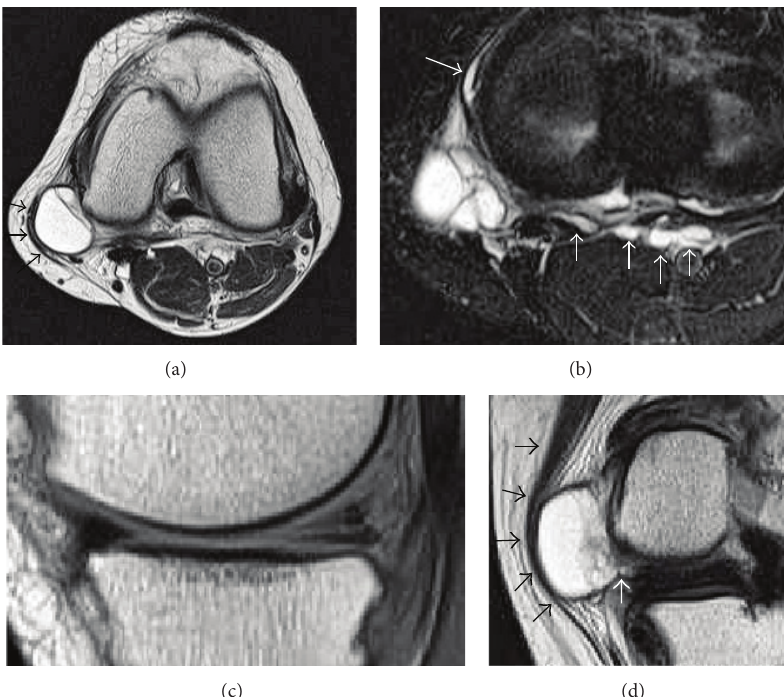
Figure 1: Preoperative magnetic resonance images of the left knee. (a) T2 weighted axial MRI shows a cystic mass measuring 23 mm × 20 mm detected on the posteromedial aspect of the knee. Flattened sartorius muscle (arrows) is noted just over the cyst. (b) Multiple daughter cysts expanding from the main large cyst to posterior and anterior directions were noted on STIR axial image (arrows). (c) A horizontal tear of the posterior segment of the medial meniscus was identified on sagittal proton image. (d) A communicating tract between the cyst and medial meniscus was identified (white arrow). Note that the flattened sartorius muscle is indicated by black